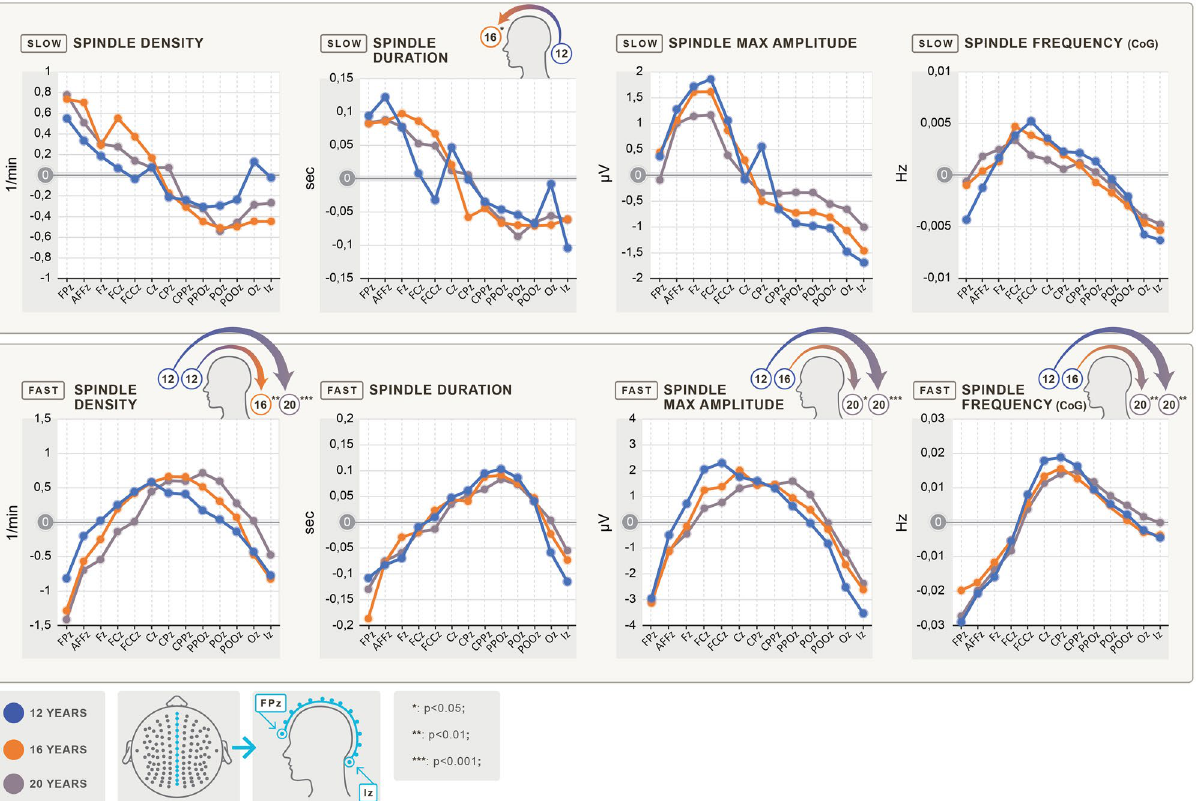
Figure 3. Age-related antero-posterior shifts in sleep spindle parameters. The spindle parameter values (y-axis) for the midline electrodes (Fpz to Iz on the x-axis, from left to right from frontal to occipital) are plotted by age groups. As the differences are significant but small (differences due to spatial position are much smaller than differences between age groups), the y-values display the difference from the mean value of the midline electrodes of the specific age group. The upper row depicts slow spindle parameters, while the lower row depicts fast spindle parameters. The different columns show different spindle parameters, such as density (1/min), duration (sec), maximum amplitude (µV) and frequency (Hz), based on the center of gravity (CoG). The small head figures above the graphs indicate significant differences and the direction of the difference in the positions of the maximum values between the specific age groups. Blue indicates 12-, orange indicates 16- and gray indicates 20-year-old subjects. Slow spindle parameters tended to shift toward the anterior region, whereas fast sleep spindle parameters tended to shift toward the posterior regions with age. The shift of the maximum values of slow spindle duration toward frontal regions was statistically significant. In terms of fast spindle density, maximum amplitude and frequency, the shift of the maximum values from central to centroparietal regions was statistically